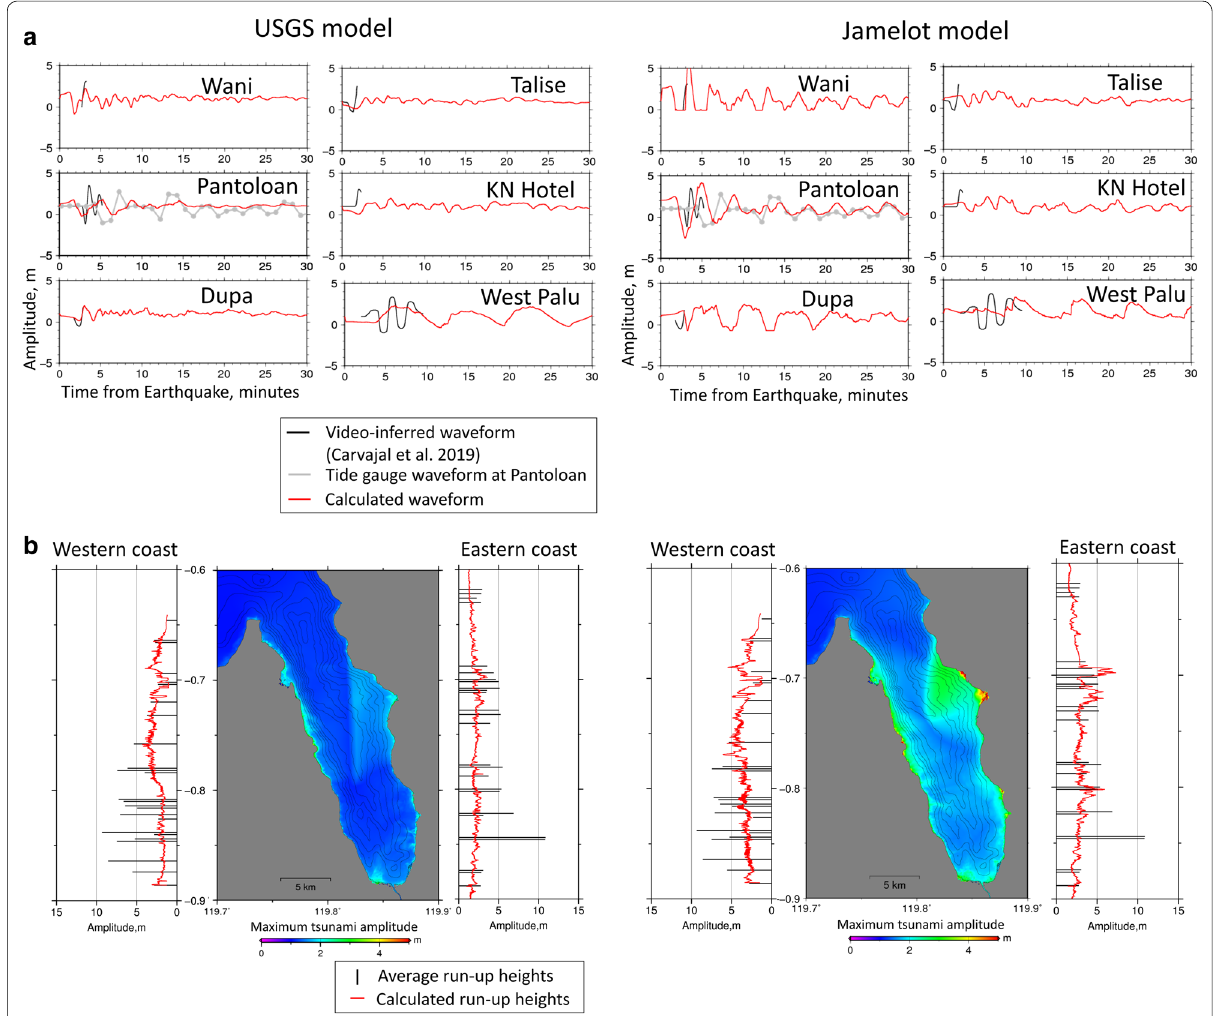
Fig. 4 Calculated tsunamis for fault models as the earthquake source (i.e., without any landslide source). The USGS (2018, left) and Jamelot et al. (2019, right) fault models are shown. a Comparison between calculated (red curves) and observed waveforms (black curves, video-inferred waveforms from Carvajal et al. (2019); gray curve, waveform at the Pantoloan tide gauge). b Distributions of the maximum calculated tsunami amplitude over the entire bay for each fault model. The color scale indicates the tsunami amplitude. Left and right graphs compare the calculated tsunami run-up heights (red curves) with those (black bars) determined by field surveys on the western and eastern coasts,